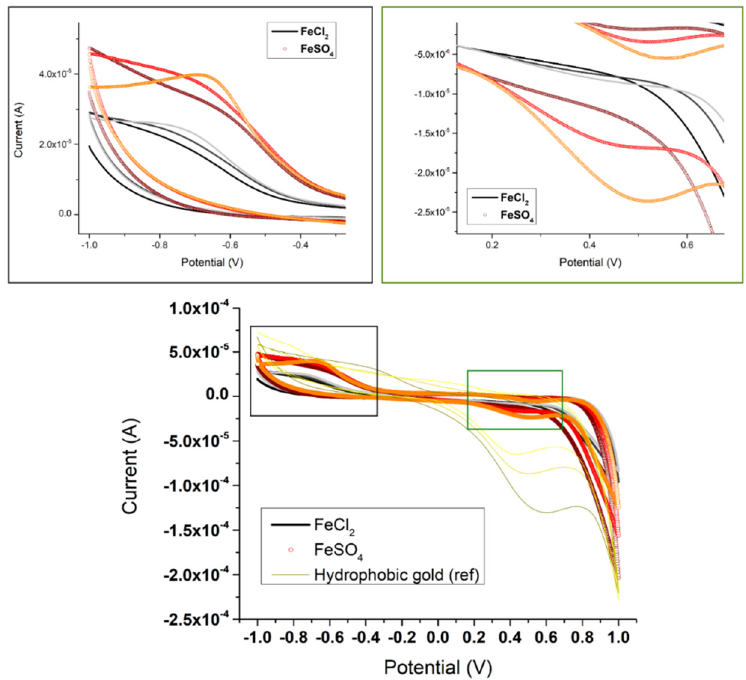
Figure 5 . Cyclic Voltammetry measurements (–1 to +1 V) reflecting the ion permeability variation of the Fe² + containing S-layers, attending to the corresponding counterion (Cl − , black to grey solid lines versus SO 42− , red to orange open circles). Experiments were performed in 0.1 M HEPES and the octanethiol-gold system (yellow to green solid lines) was employed as signal reference.